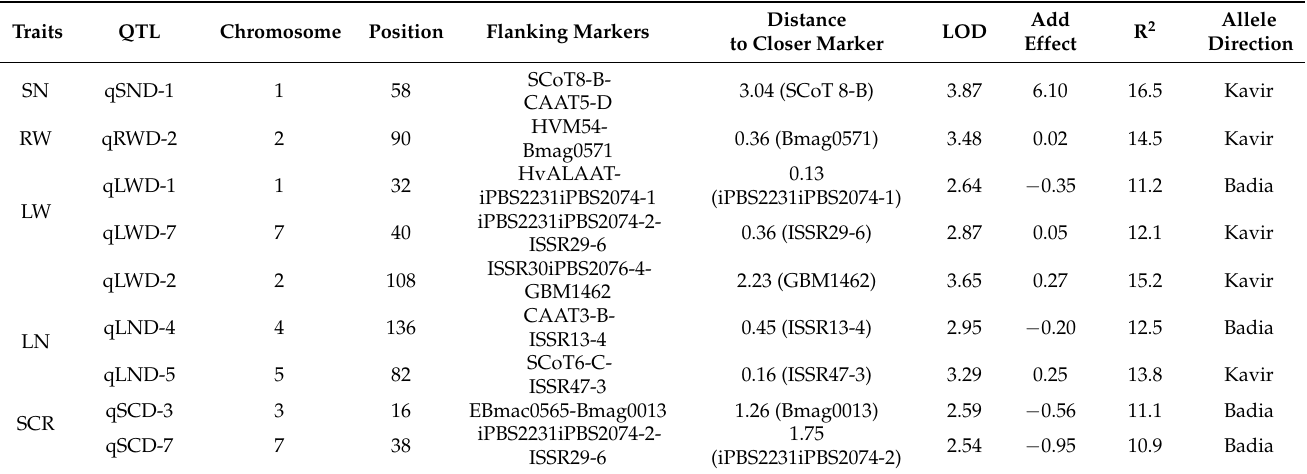
Table 9. QTLs controlling traits in barley under normal conditions at the seedling stage in an RIL population caused Kavir and Badia